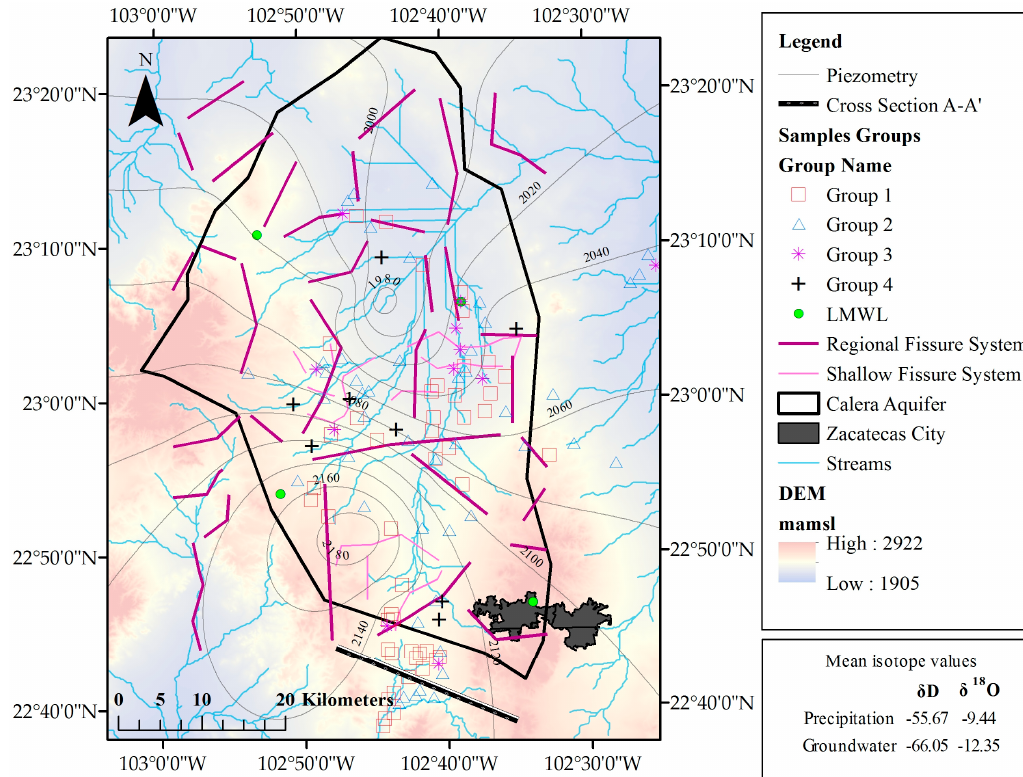
Figure 5. Geospatial distribution of sampled groups, fissure systems, and streams in the study area.